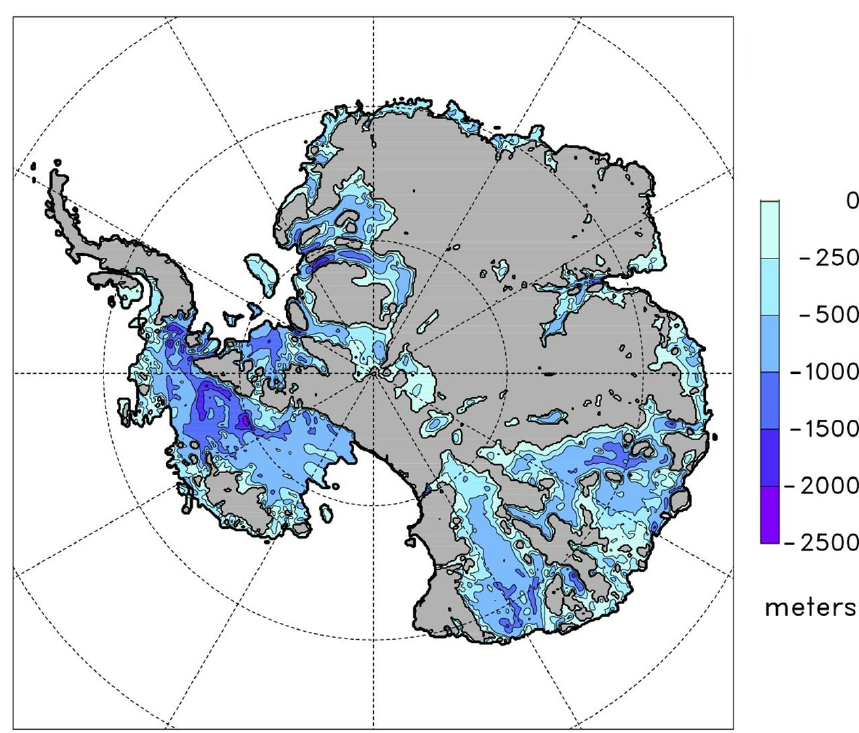
Figure 11. Modern observed Antarctic bedrock elevations where below sea level, aggregated to the 10km model grid from Bedmap2 (Fretwell et al., 2013). As in Fig. 1b of Pollard et al. (2015).